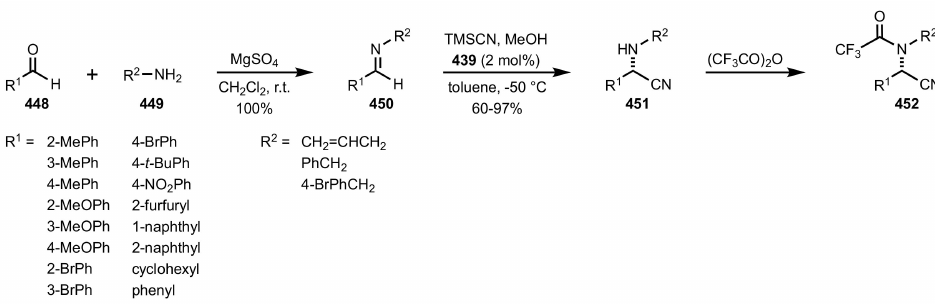
Scheme 118. Strecker reaction catalysed by 439